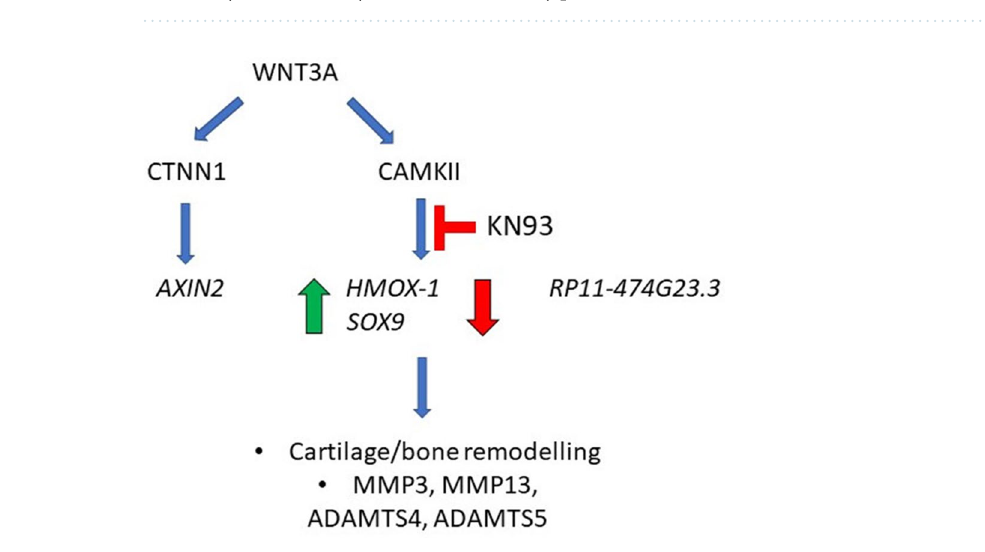
Figure 6. CaMKII inhibition enhanced the capacity of IL1B to upregulate catabolic enzymes in the articular chondrocytes. ( a – h ) mRNA expression of ADAMTS4/5 and MMP3/13 measured by qPCR of bovine articular chondrocytes stimulated for 24 h with IL1B (20 ng/ml) in presence or absence of KN93 or its inactive analogue KN92 (both 10 µM) ( a , c , e , g ) or in the presence or absence of the CaMKII inhibitor AIP ( b , d , f , h ) (5 µM). Data were analysed with 2 ways ANOVA and Tukey post-test. n = 3.